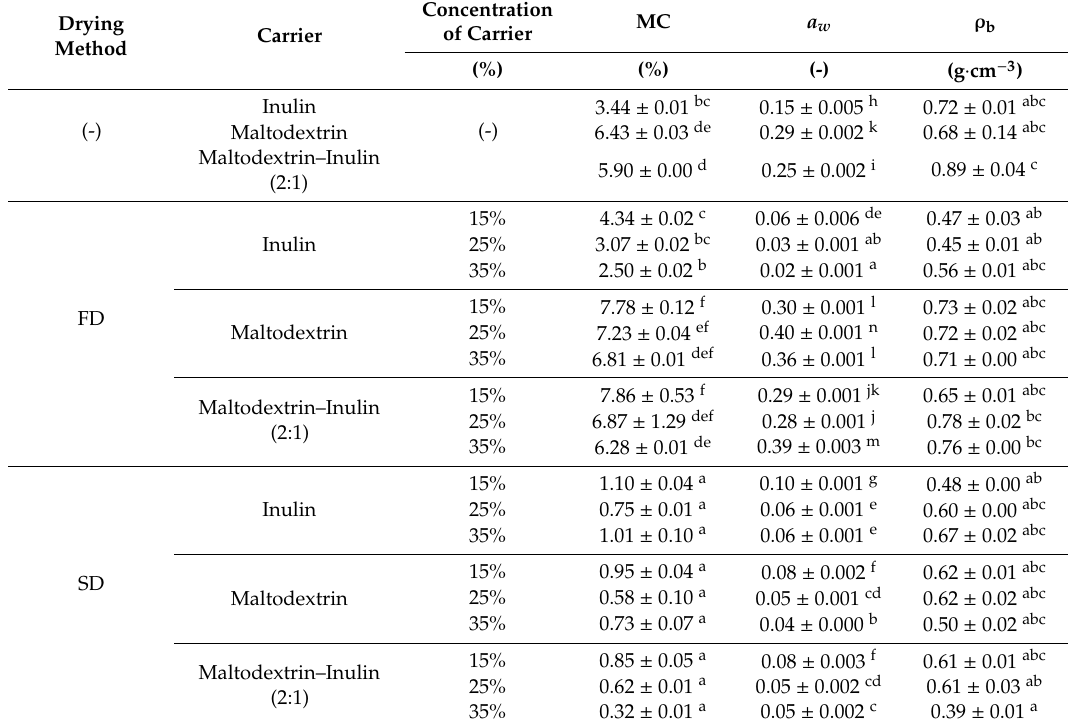
Table 1. Physical properties of carriers and freeze- and spray-dried cranberry powders ( n = 2), average ± standard